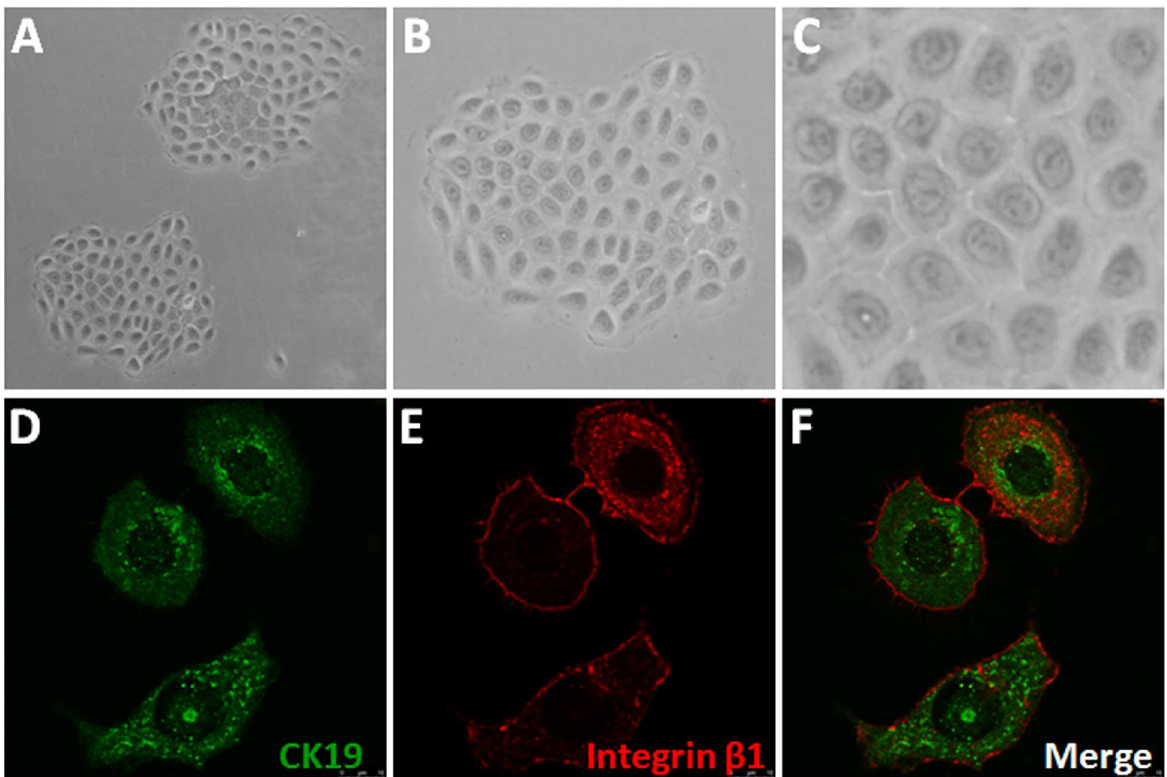
Fig 1. Characterization of isolated and cultured cells. (A) Cells behavedlike clonogenic stem cells in vitro ( × 100).(B) Magnification of (A) ( × 200).(C) Magnification of (B) ( × 400). (D-F) The cells expressed integrin β 1 and CK19 (immunofluorescence, × 1000).